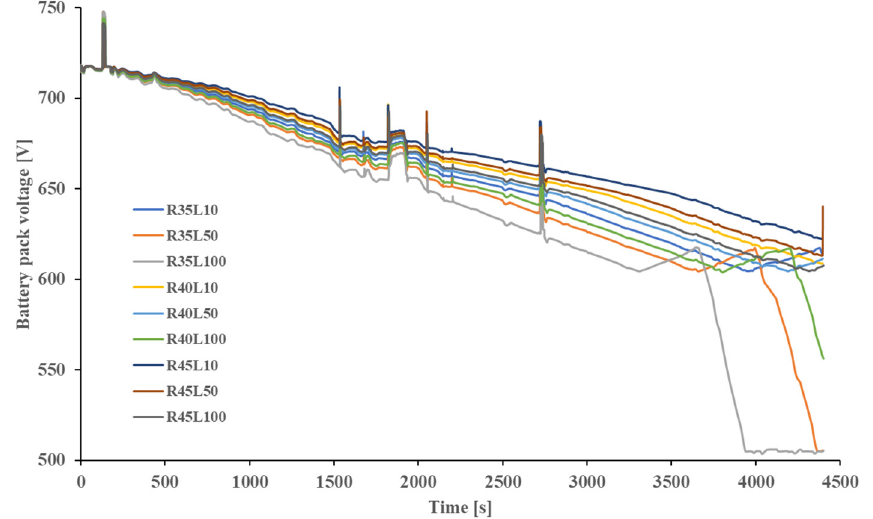
Figure 11. The battery pack voltage variations during travel for different scenarios.